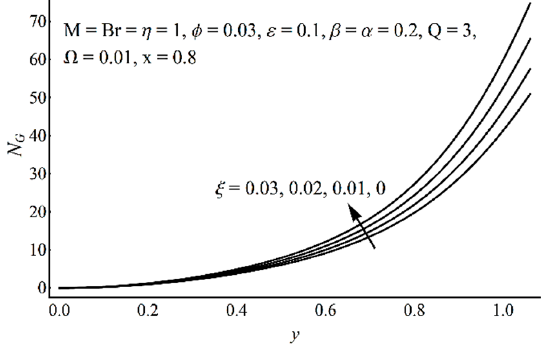
Figure 21. The total entropy generation number against various ξ values.